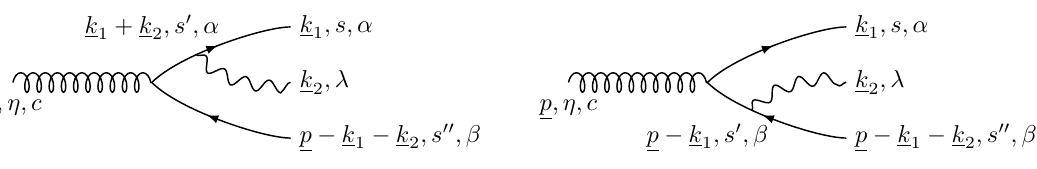
Figure 2 . The dressed gluon state to order O ( g e g s ), with the photon being emitted either from the quark (left) or from the antiquark